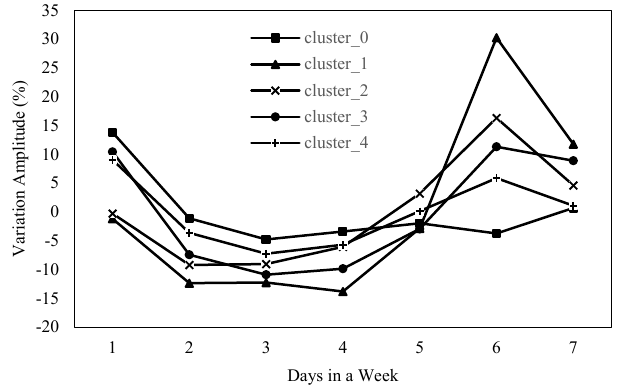
Figure 10. Variation in cluster centers based on emigration. Table 4. Clustering results based on emigration.